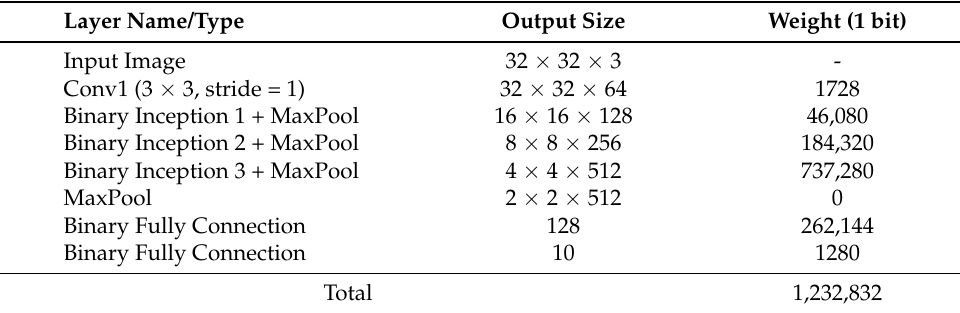
Table 1. Proposed multi-scale BNN typology’s layer structure and weight